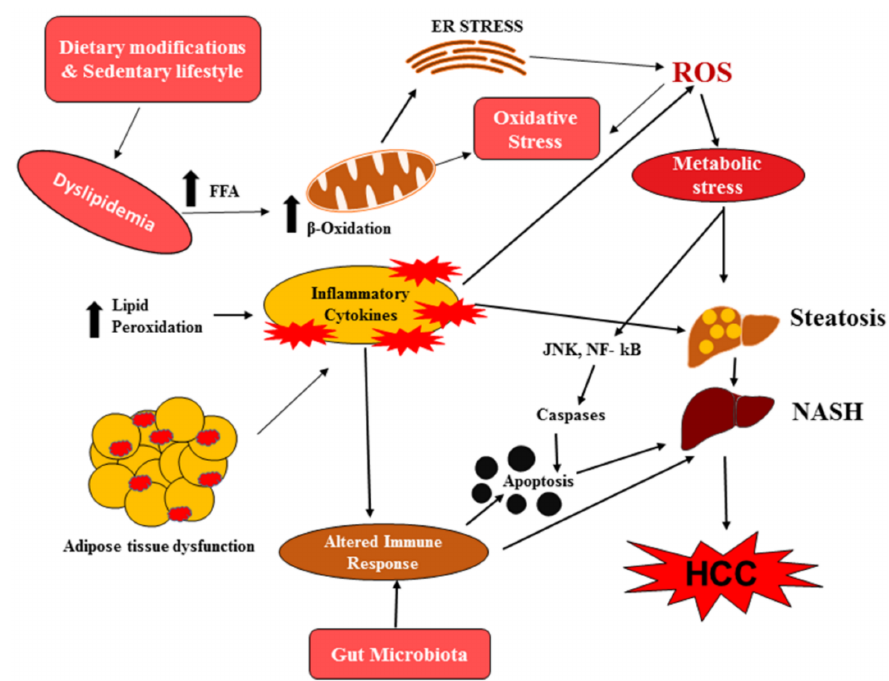
Figure 4. Schematic representation of metabolic and molecular changes associated with apoptotic pathway in nonalcoholic fatty liver disease (NAFLD) and hepatocellular carcinoma (HCC). Histone acetylation of sterol 12 α -hydroxylase (CYP8B1) gene promoter induced by